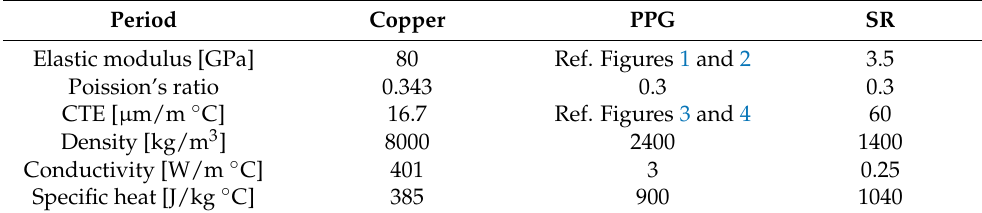
Figure 14. Finite element modeling. Table 4. CTE of PPG in a y direction.